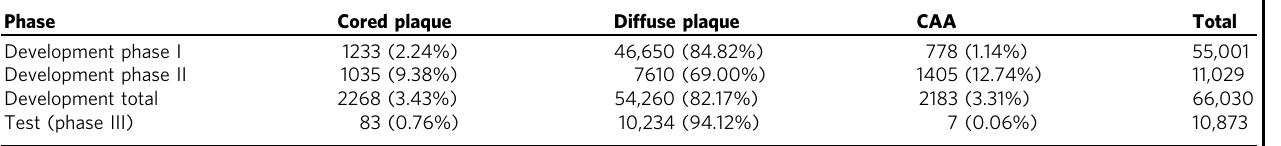
Remaining unlisted percentages correspond to Not Sure or Flagged labels (see